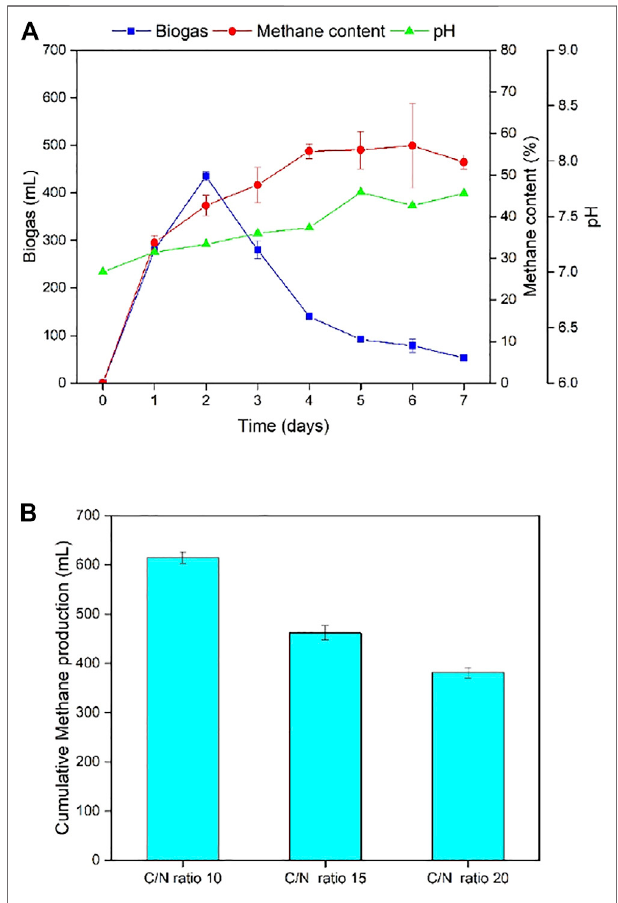
FIGURE 6 | (A) Daily biogas production, methane content, and pH for theC/Nratioof10. (B) CumulativemethaneproductionforTS-ADoperatedat different C/N